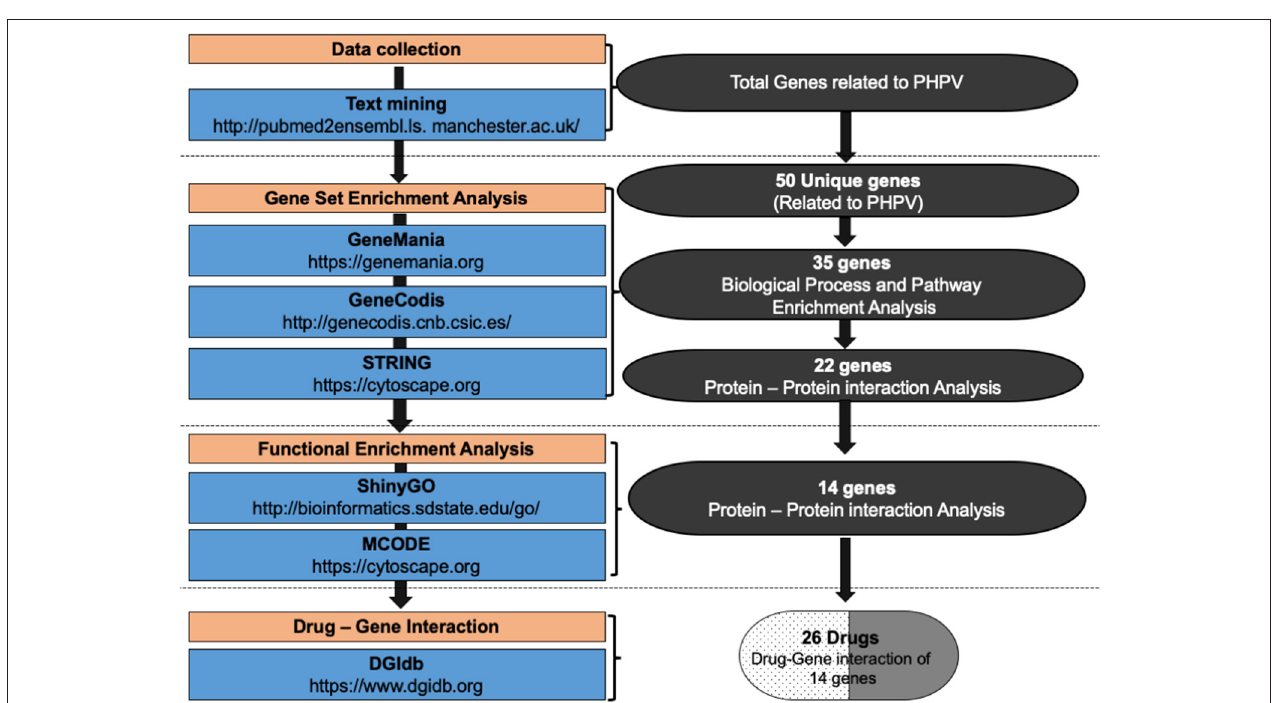
FIGURE 2 | Summary of the study design and methodology flowchart. Text mining was conducted using pubmed2ensembl to identify genes associated with persistent hyperplastic primary vitreous (PHPV). GeneCodis was used to detect genes enriched in Gene Ontology (GO) biological process terms and KEGG pathways. STRING and MCODE software were used to construct a protein-protein interaction network and identify modules. The GO biological process terms and KEGG pathways were analyzed using DAVID, ClueGO, and ShinyGo. The drug list was compiled based on the gene-drug interaction using the drug-gene interaction database